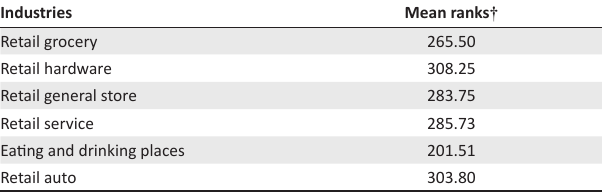
TABLE 10: Mean ranks for Hypothesis 1.